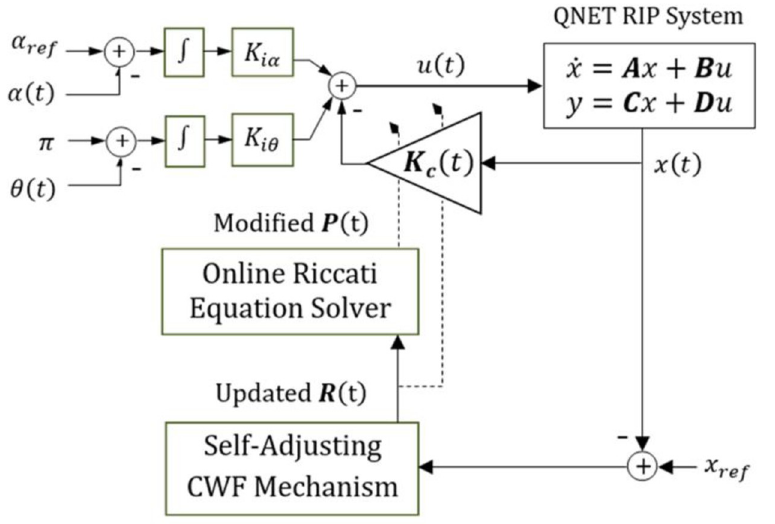
Fig 4. The block diagram of the